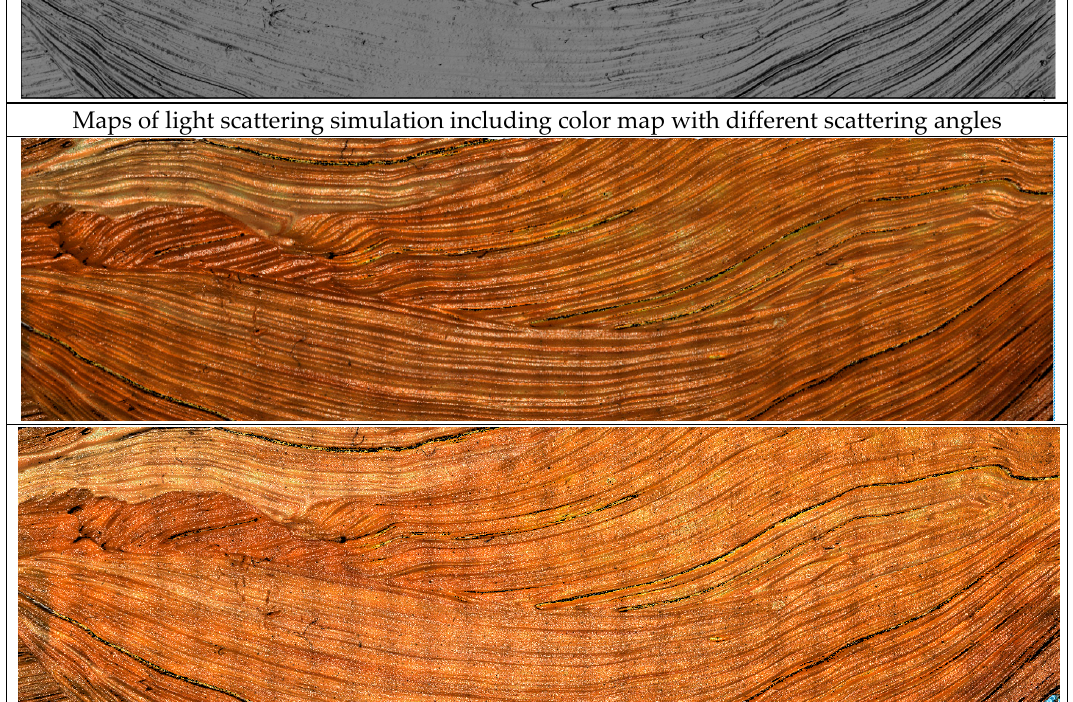
Figure A3. Light scattering simulation of the topographic map shown in Figure A1.